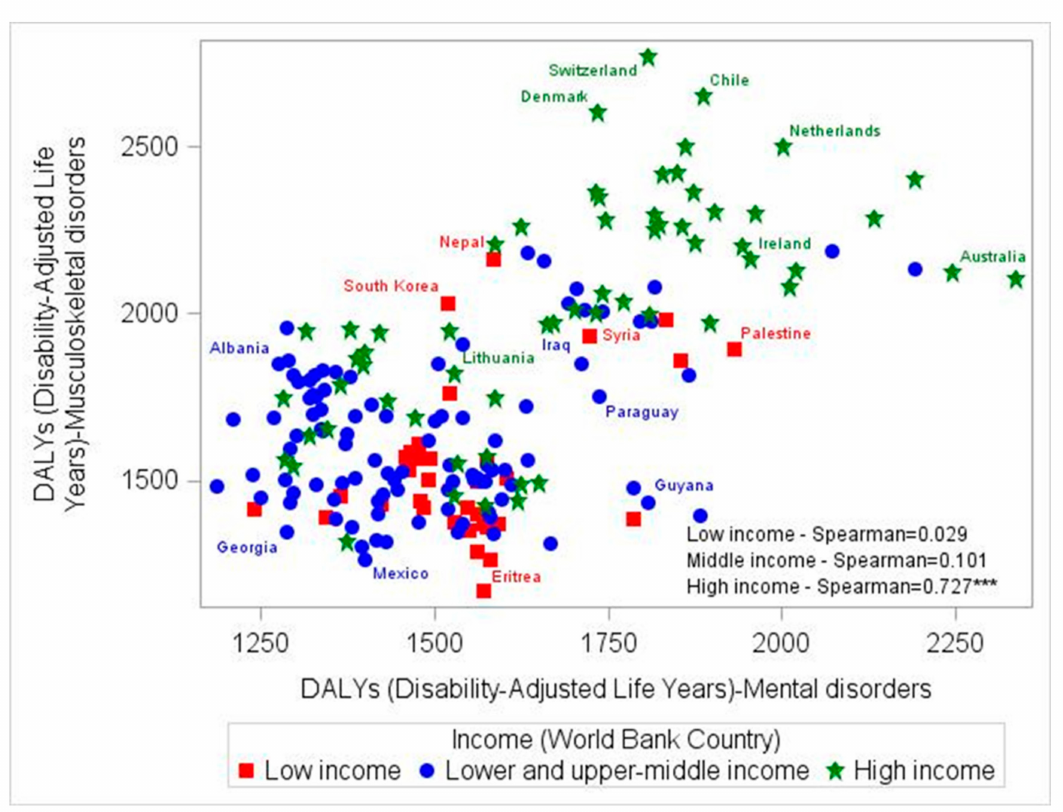
Figure 4. Correlation between age-standardized musculoskeletal and total mental disorders (MDT) DALYs among 195 countries, analyzed by income level, for 2017. DALYs: Disability-adjusted life-years. *** p <